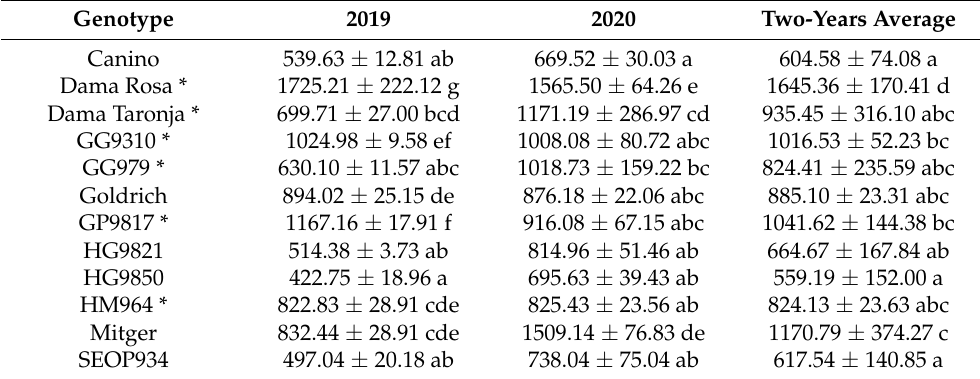
Table 1. Polyphenol total content (mg/100 g DW). Average ± standard deviation. Different letter means significant differences among genotypes. Varieties with * produced fruits with a red-blush on the skin